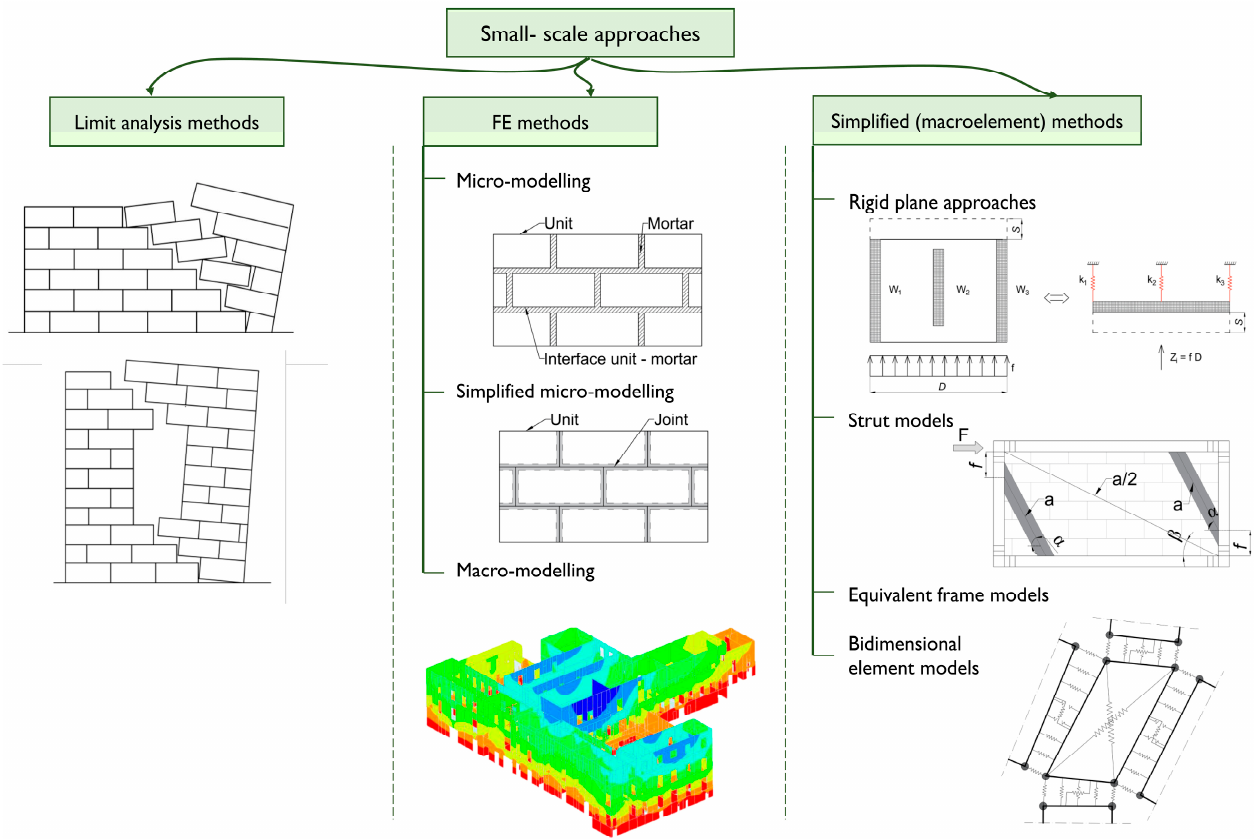
Figure 2. Categories of small-scale approaches.